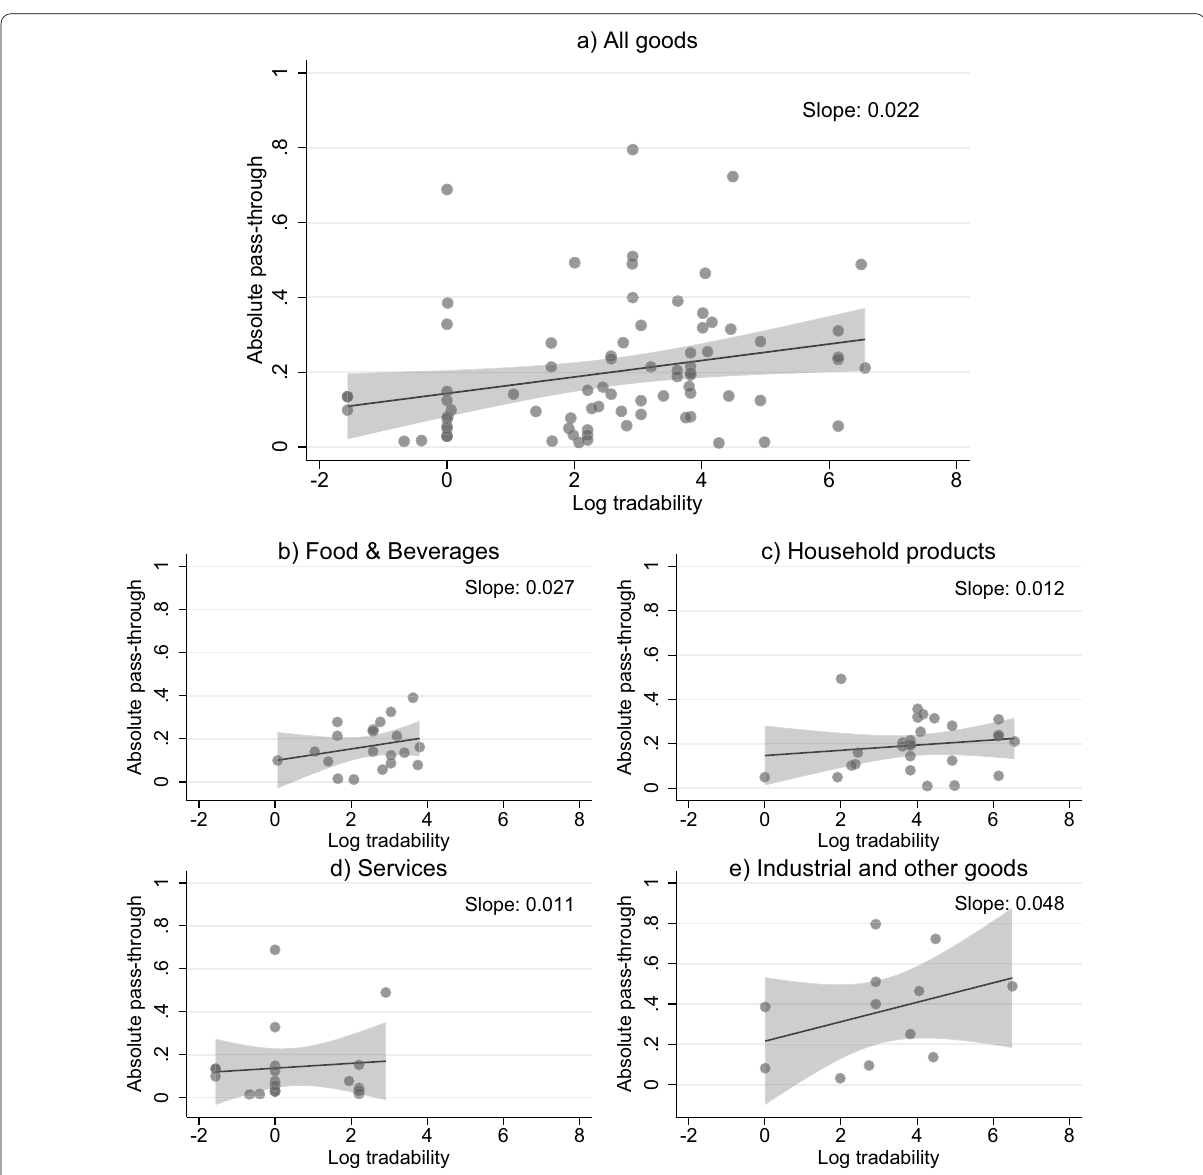
Fig. 5 International tradability and pass-through across HICP categories. Notes: Linear regression of the synthetic pass-through estimates on tradability for HICP goods and services, separated by class. The slope of the regression lines are shown in the charts. Tradability is taken in log value due to how it is computed in the BLS index of Johnson (2017), with most values in the 0–50 range and some extreme values in the 600–700 range. Pass-through is taken in absolute value due to a few negative values. Bands show the 95% confidence interval of the